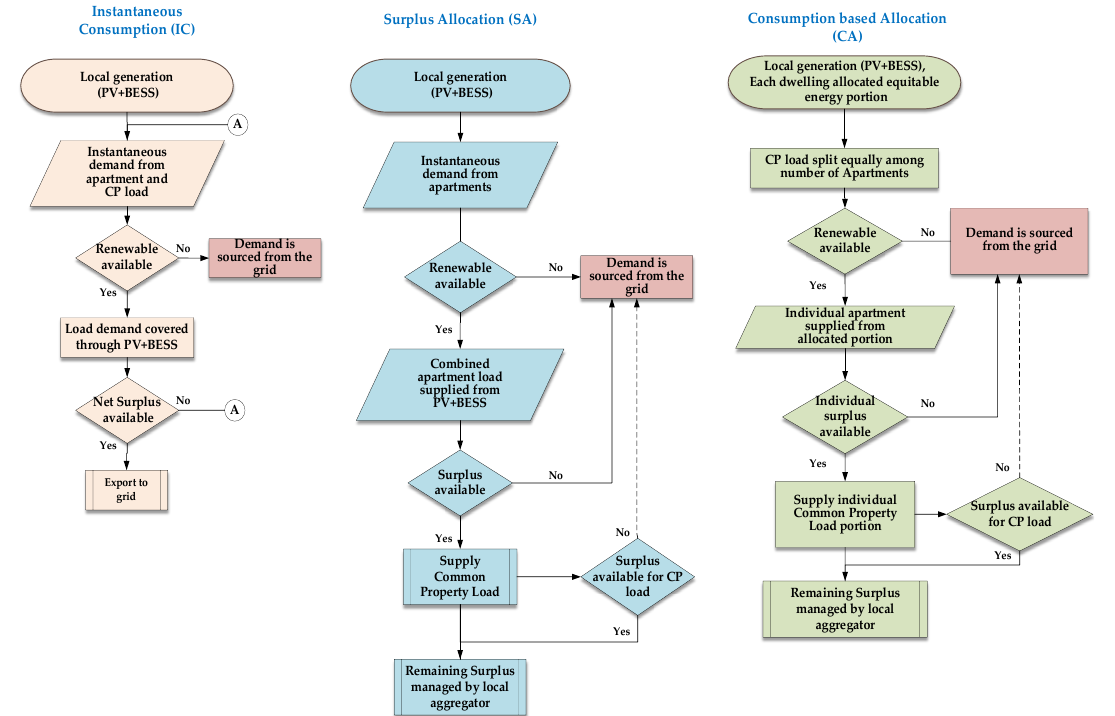
Figure 7. Energy allocation strategies workflow for offsetting CP load demand.